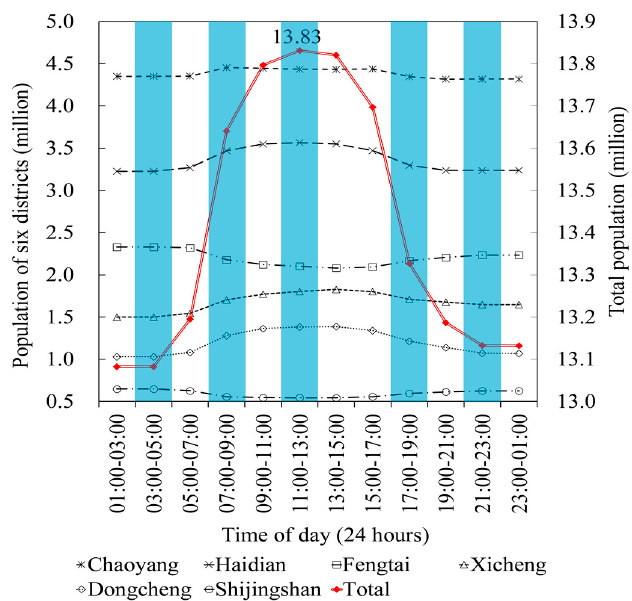
Figure 2. Bi-hourly variation of the total population in the central area of Beijing.